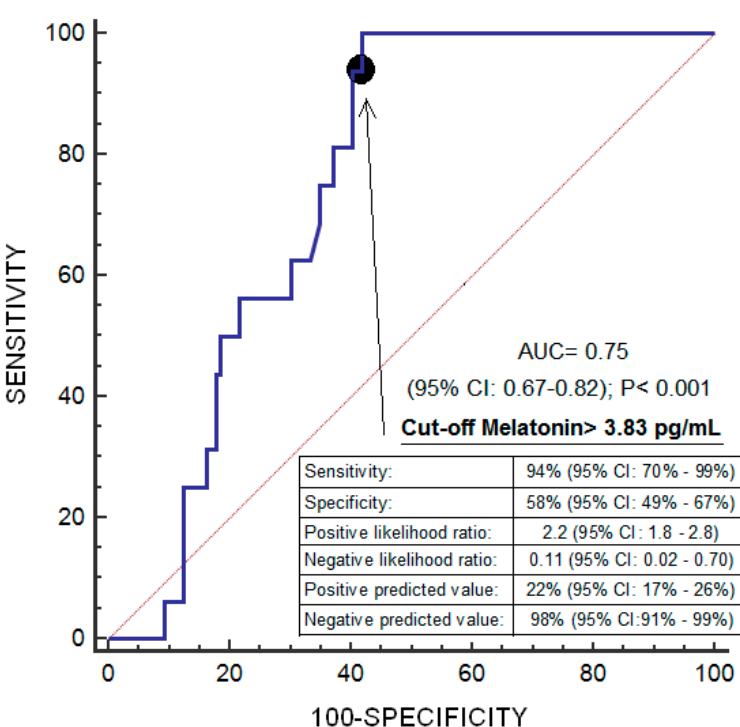
Figure 1. Receiver operation characteristic (ROC) of serum melatonin levels prior to liver transplantation due to hepatocellular carcinoma for the prediction of one-year liver transplantation survival.